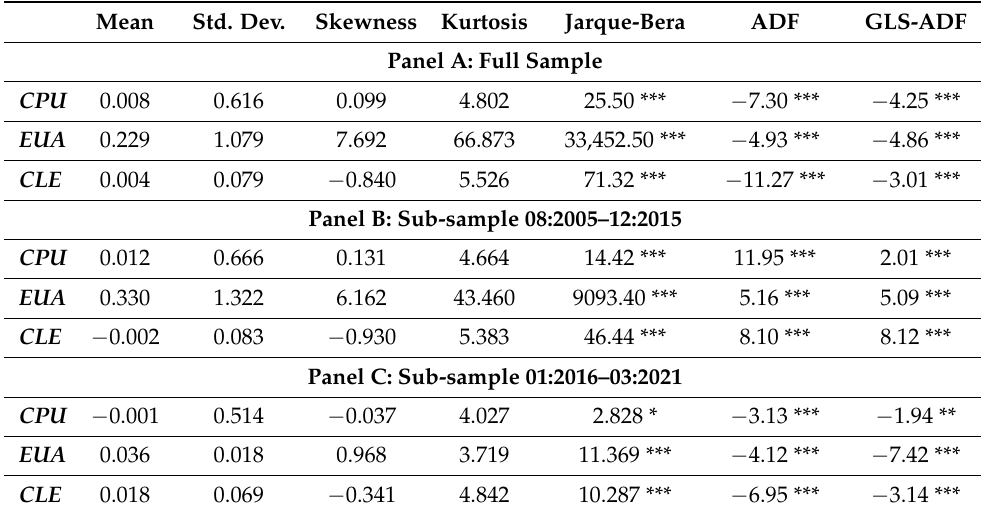
Table 1. Descriptive statistics and unit root test.